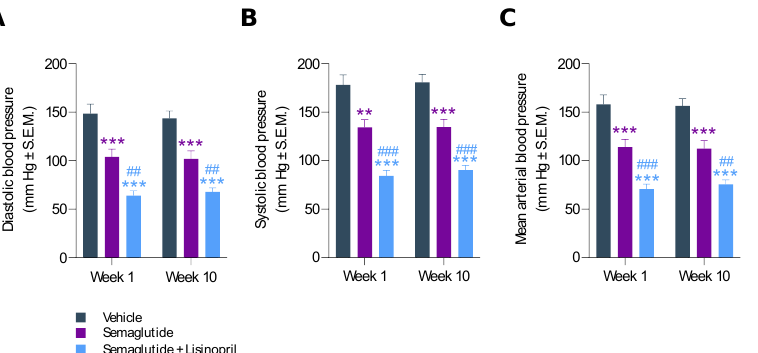
Figure 3. Semaglutide improves hypertension in db / db UNx-ReninAAV mice. ( A ) Diastolic arterial blood pressure. ( B ) Systolic arterial blood pressure. ( C ) Mean arterial blood pressure. Blood pressure was measured by tail cuff plethysmography in treatment week 1 and 10. Semaglutide monotherapy (30 nmol/kg, s.c, q.d., n = 15) and combination treatment with lisinopril (30 mg/kg, p.o., q.d., n = 14) was performed for 11 weeks in db / db UNx-ReninAAV mice. Vehicle-dosed (s.c, q.d.) db / db UNx-ReninAAV mice ( n = 15) served as controls. ** p < 0.01, *** p < 0.001 vs. vehicle-dosed db / db UNx-ReninAAV mice. ## p < 0.01, ### p < 0.001 vs. semaglutide (Dunnett’s test one-factor/two-factor linear model with interaction).